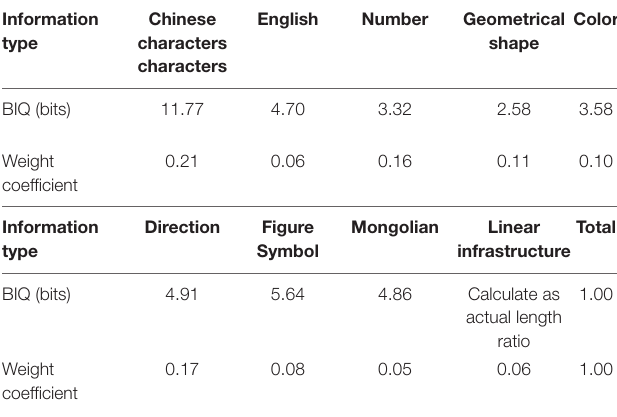
TABLE 1 | BIQ and coefficient of 9 types of information on grassland